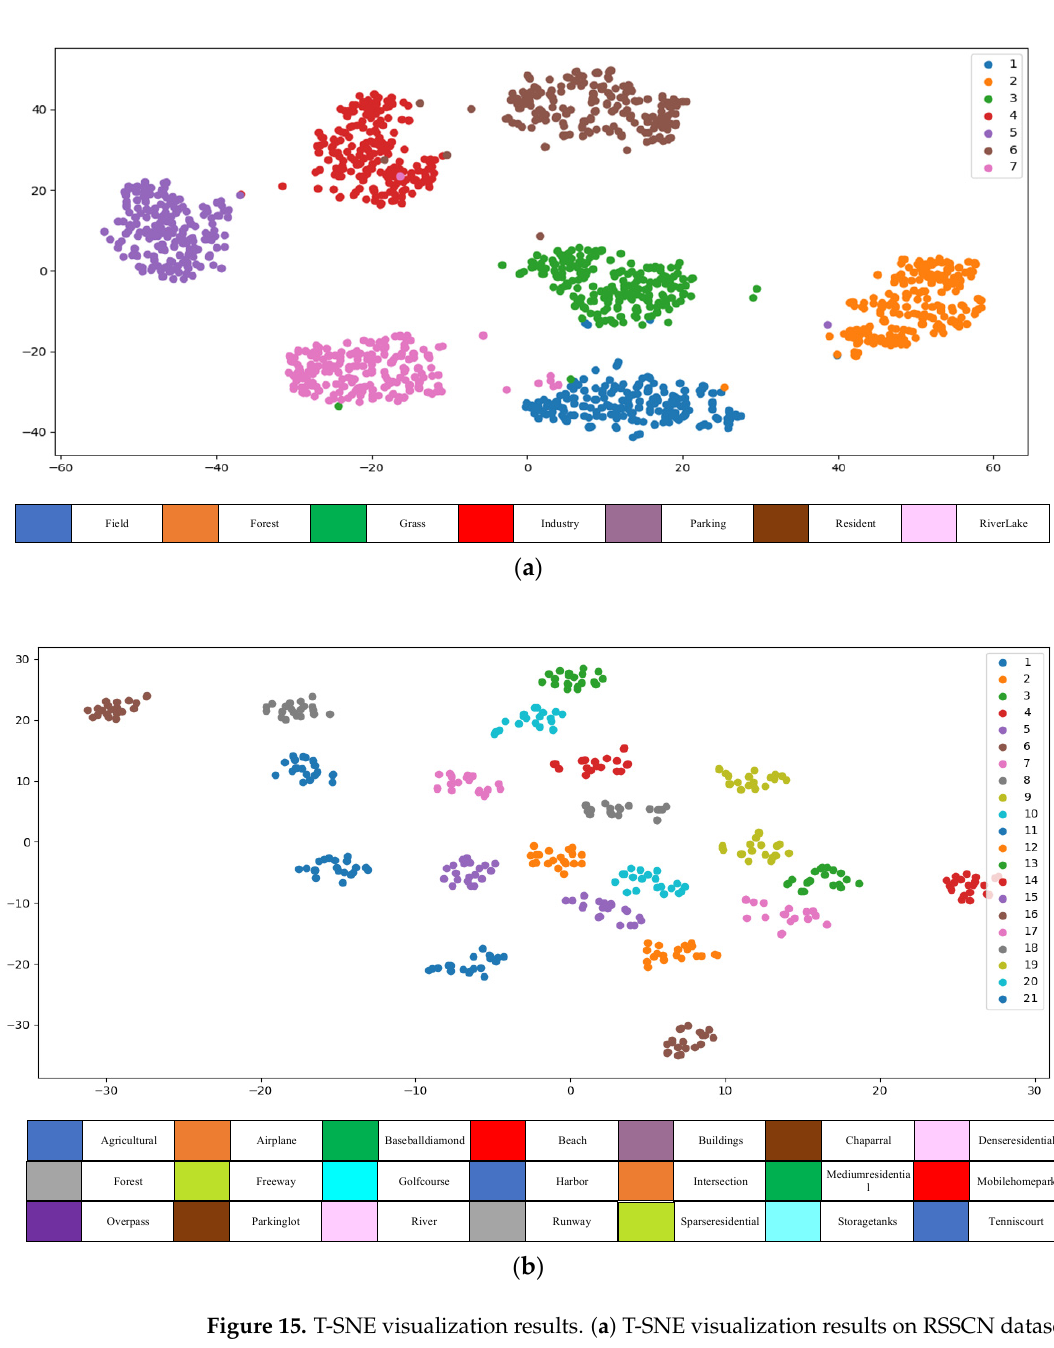
Figure 15. T-SNE visualization results. ( a ) T-SNE visualization results on RSSCN datasets. ( b ) T-SNE visualization results on UC datasets.